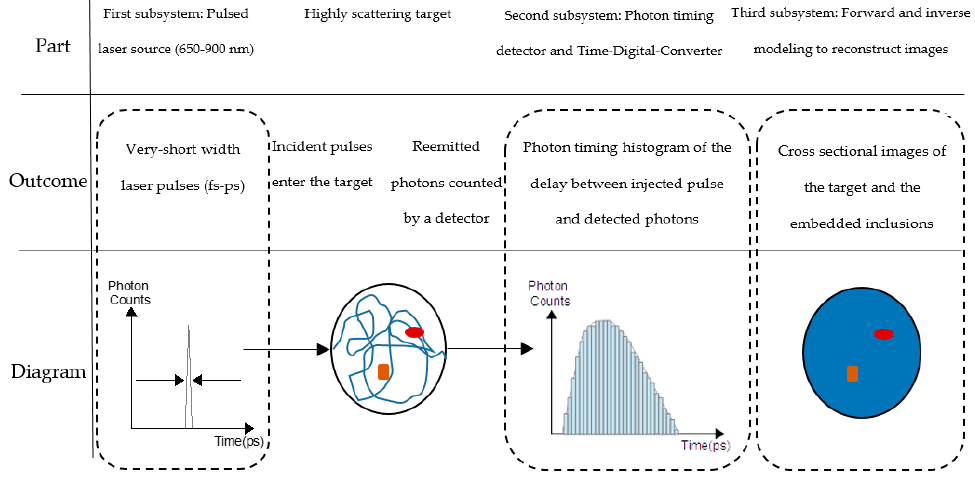
Figure 1. Main components of a typical TR-DOI prototype and the role for each one. From left to right: light illumination, turbid, photon timing, image reconstruction tool.